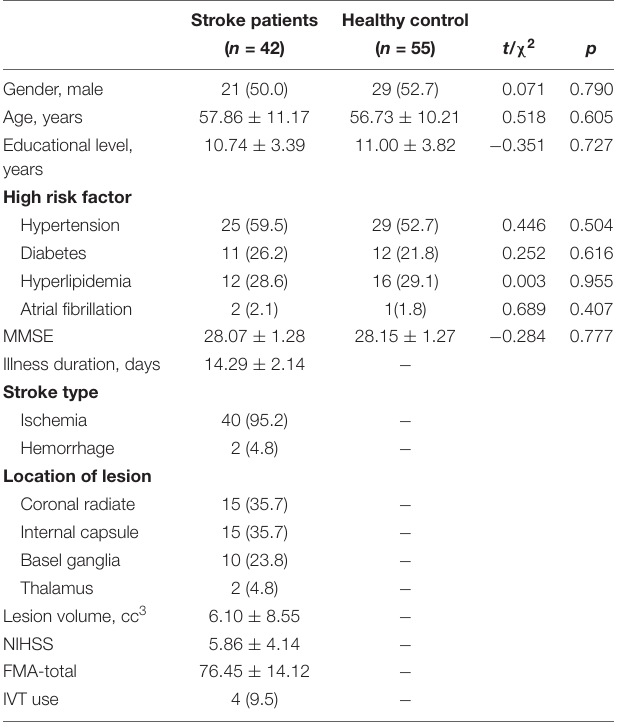
TABLE 1 | Demographic and clinical